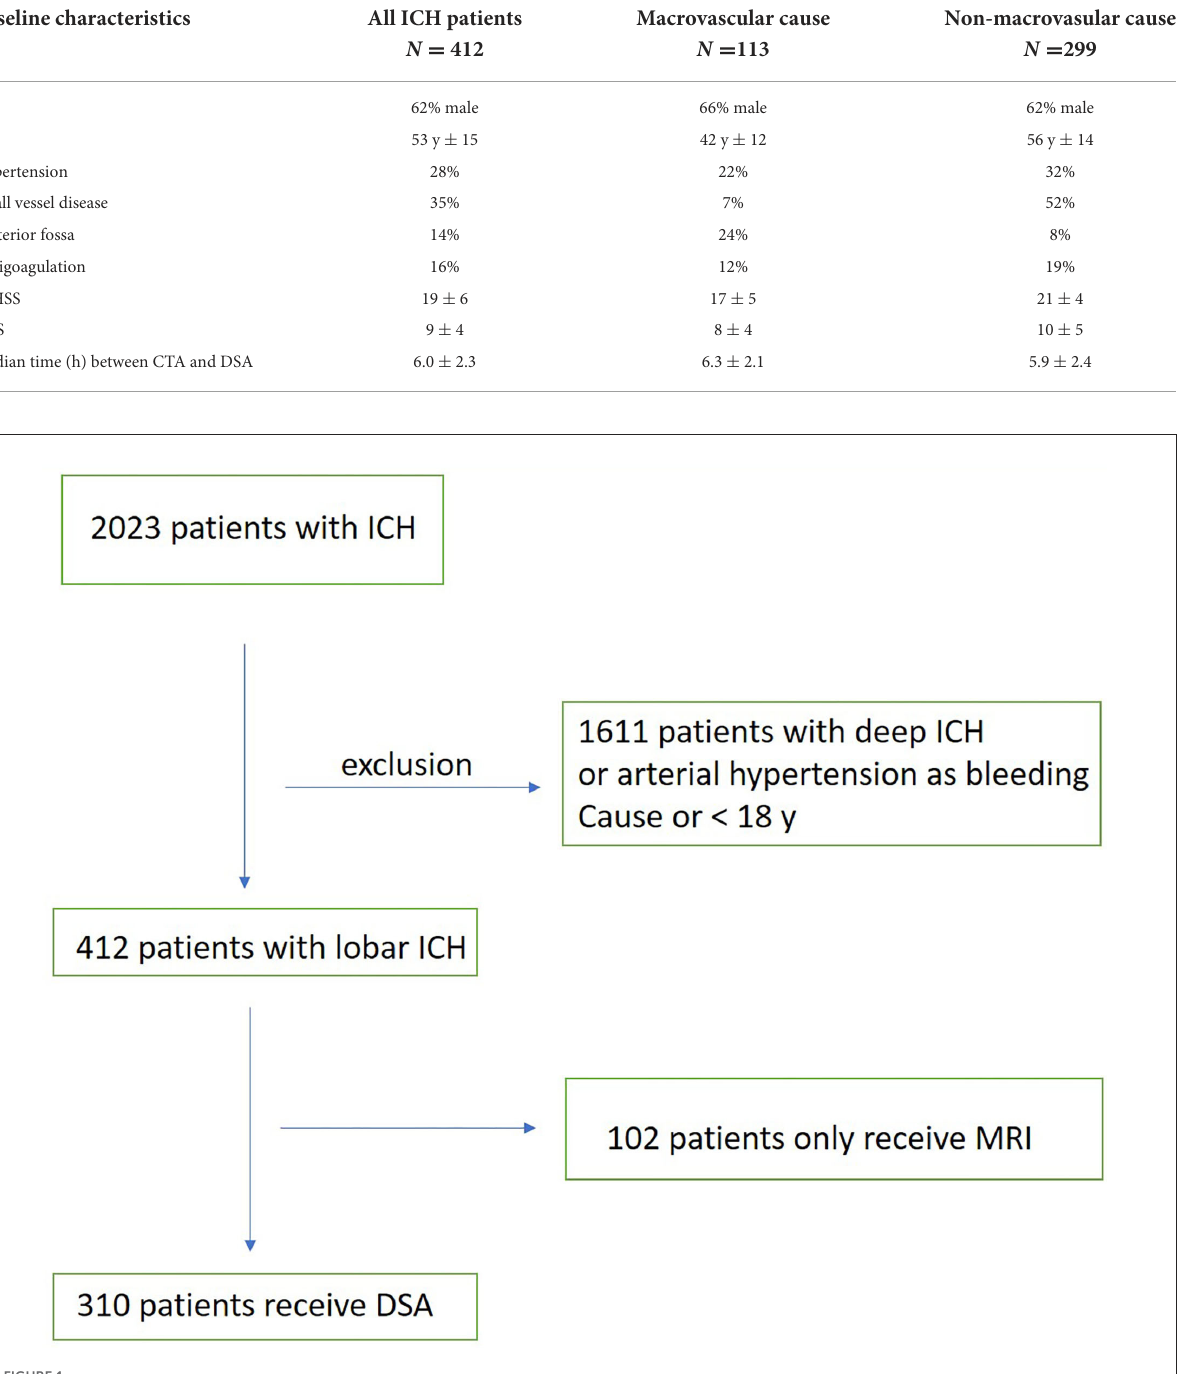
Baseline characteristics are shown in Table 1. The DSA detected a macrovascular cause of bleeding in 125/412 patients (33%). Out of the 125 patients, 60 patients had AVMs (15%) (Figure 2), 30 patients had aneurysms (7%), 12